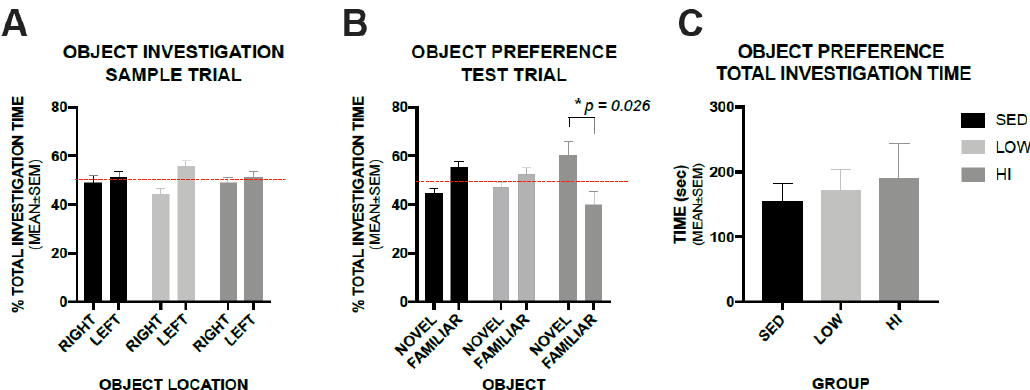
Figure 5. High-intensity exercise training increased preference for the novel object as shown by an increased percentage of investigation time compared to the familiar object, but low-intensity exercise training does not. Panel A shows percent of total investigation time for each group between similar objects placed on the right and left sides of the test area. Panel B shows percent of total investigation time between novel and familiar objects when one of the similar objects was replaced by a novel object. Dashed line represents 50% or equal preference. Panel C shows total investigation time during the test trial. Values represent the mean ± s.e.m.